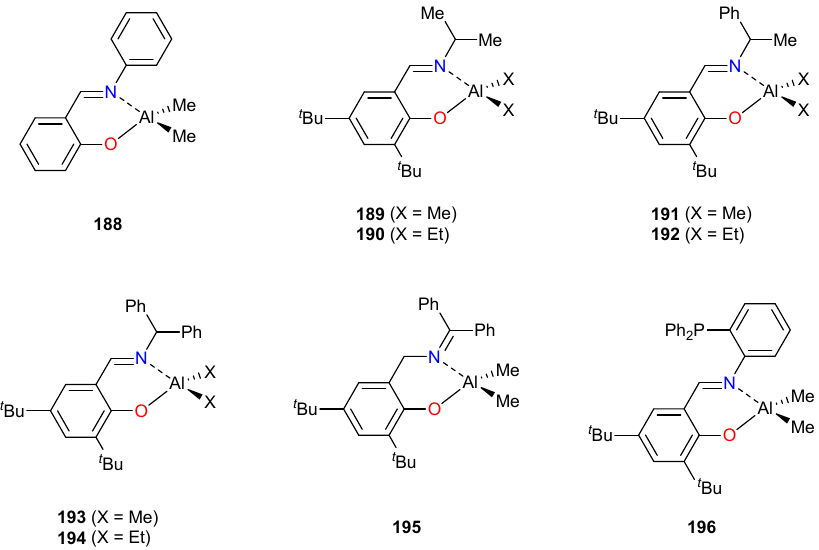
ff -bases tested in the ROP of cyclic esters Figure 34. Al-complexes of bidentate Schiff-bases tested in the ROP of cyclic esters [109,110]. Figure 34. Al-complexes of bidentate Schi